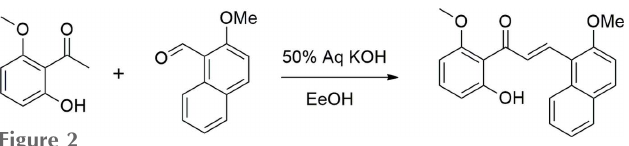
Figure 2 Synthetic scheme for the preparation of the title compound.